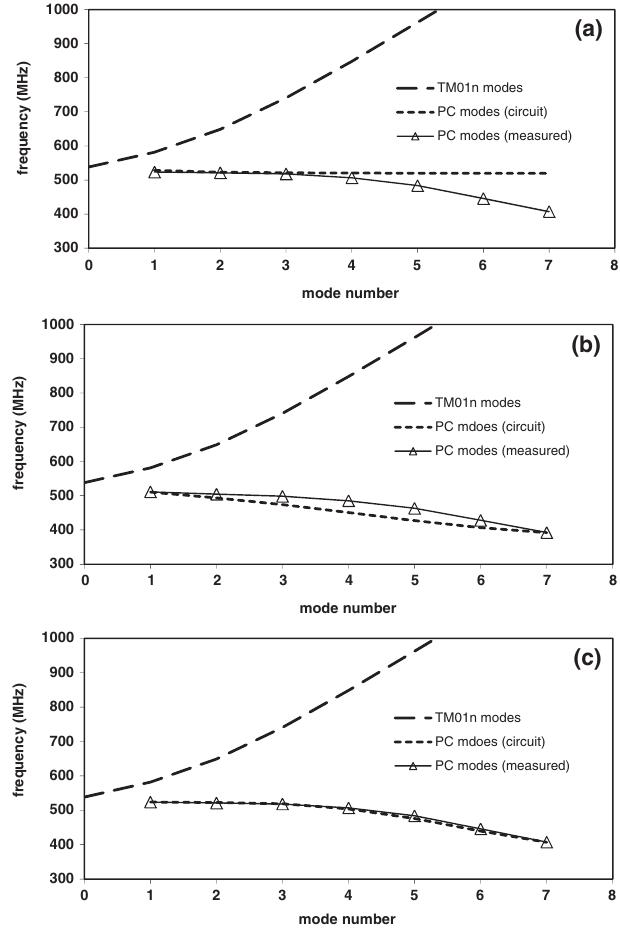
FIG. 19. PC dispersion curve computed by equivalent circuit without PC coupling (a), with nearest neighbor PC coupling (b), and next nearest neighbor PC coupling